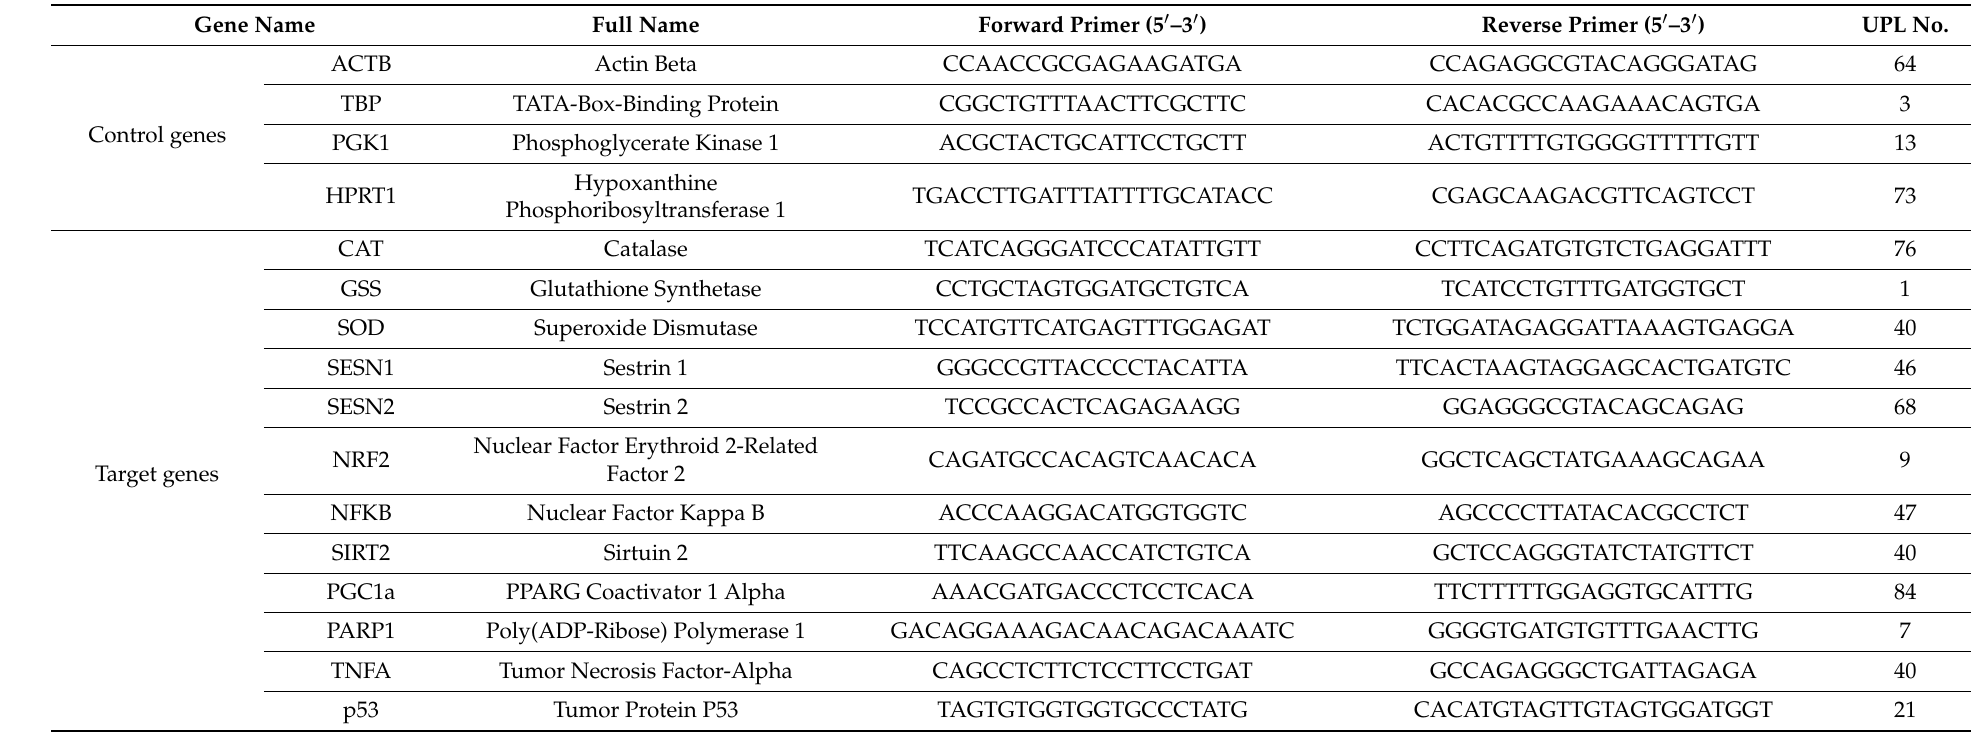
Table 1. List of primers used for real-time PCR